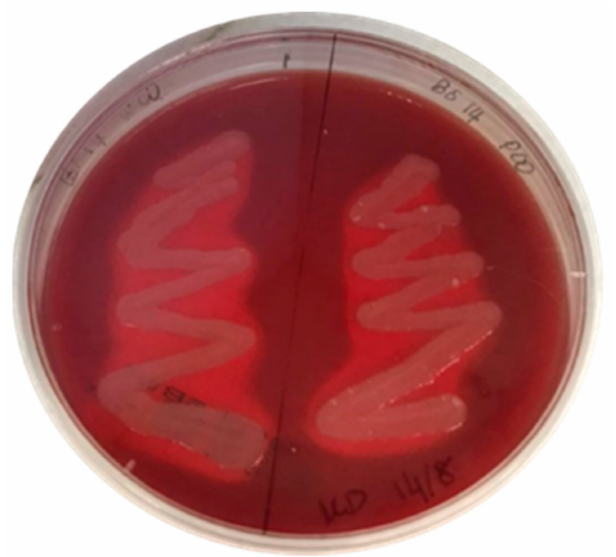
Figure 4. BS14 consortium inoculated from WCO (left) and PCO (right) media demonstrating β -haemolytic activity on a blood agar plate after a 2 days